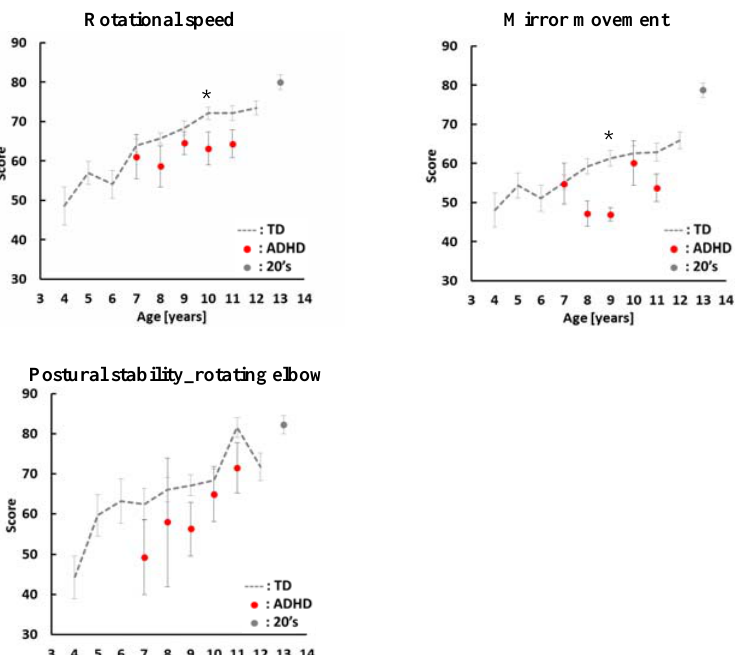
Figure 2. Average scores and standard errors in the maximal-effort motor task. The average score of children with ADHD is indicated by the red dots. The gray dashed line shows the average score of TD children. Gray dots show the average scores of adults aged 21–29 years old. *: p <